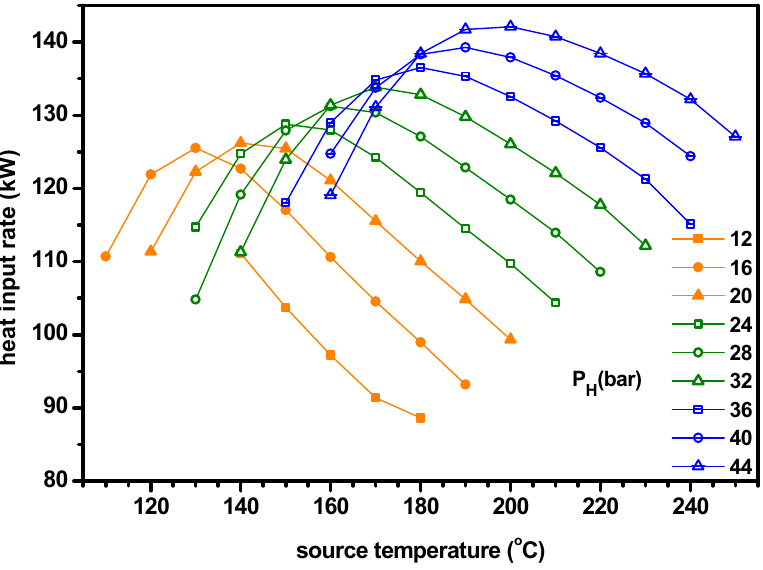
Figure 15. E ff ect of source temperature on the heat input Figure 15. Effect of source temperature on the heat input rate.